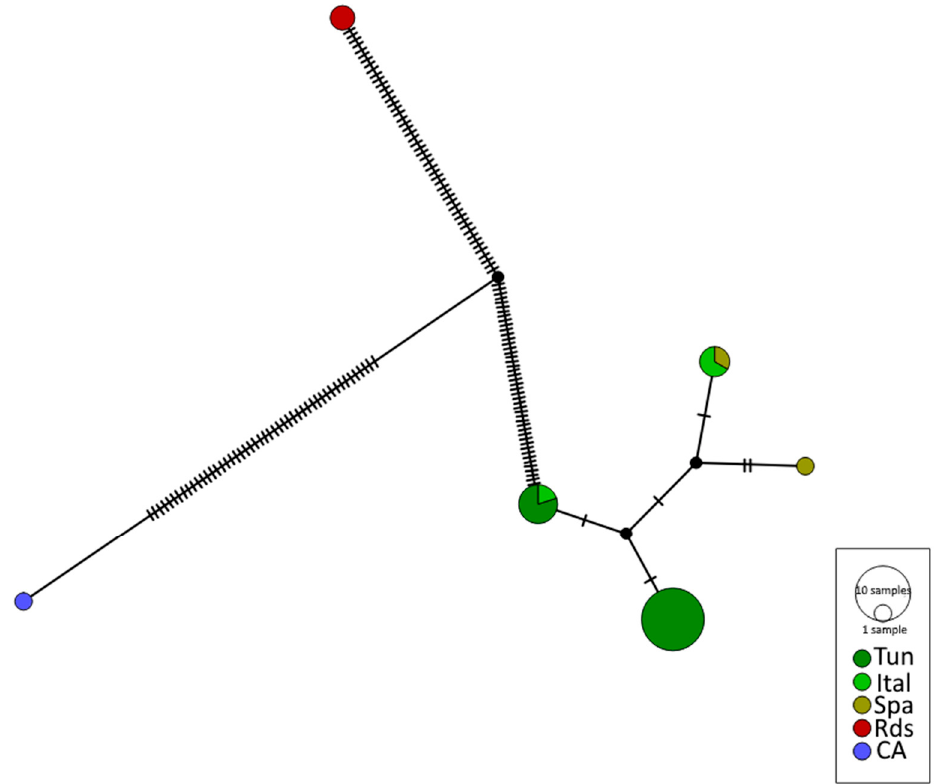
Figure 4. Mitochondrial DNA haplotype network of Holothuria impatiens ; the different colors corre- spond to the different geographical areas: (Tu) Tunisia, (Ital) Italy, (Spa) Spain, (Rds) Red Sea, and, as an external group, (CA) Canada for the species Cucumaria frondosa . The diameter of each circle is proportional to the frequencies of the haplotypes. In the case where the haplotypes are shared between the stations, the colors represented are proportional to the frequencies of the haplotypes of the stations.